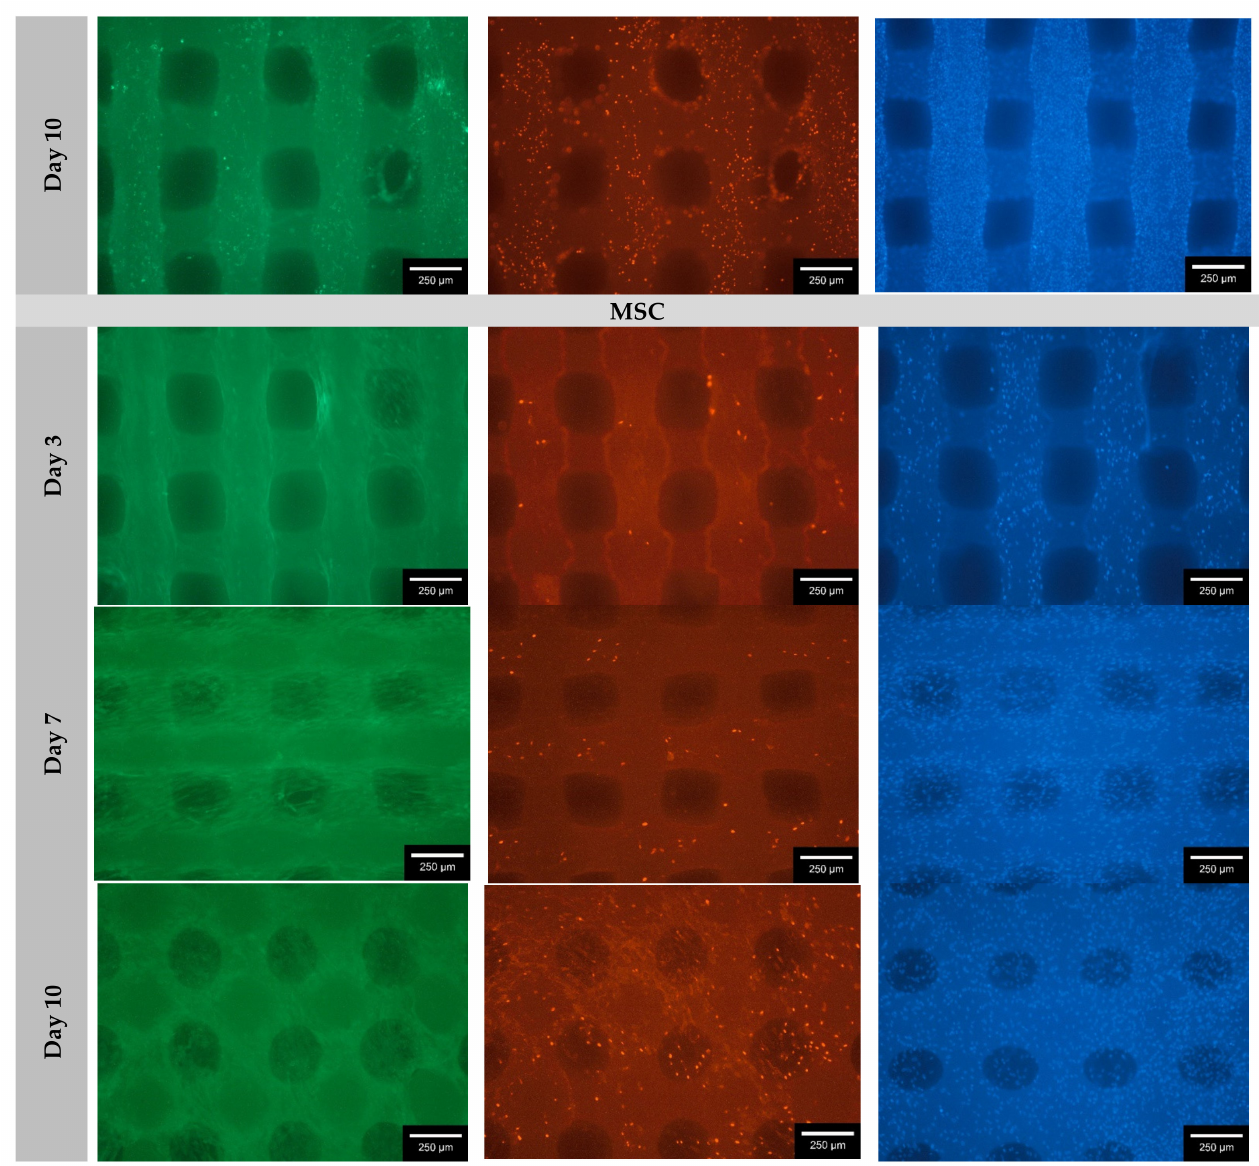
Figure 5. Comparison of total, living and dead cells of three different cell types (MG-63, MLO-4 and MSC) on the surface of the collagen coated PCL scaffolds at 3 different time points, images taken with Olympus BX-53 flourescense